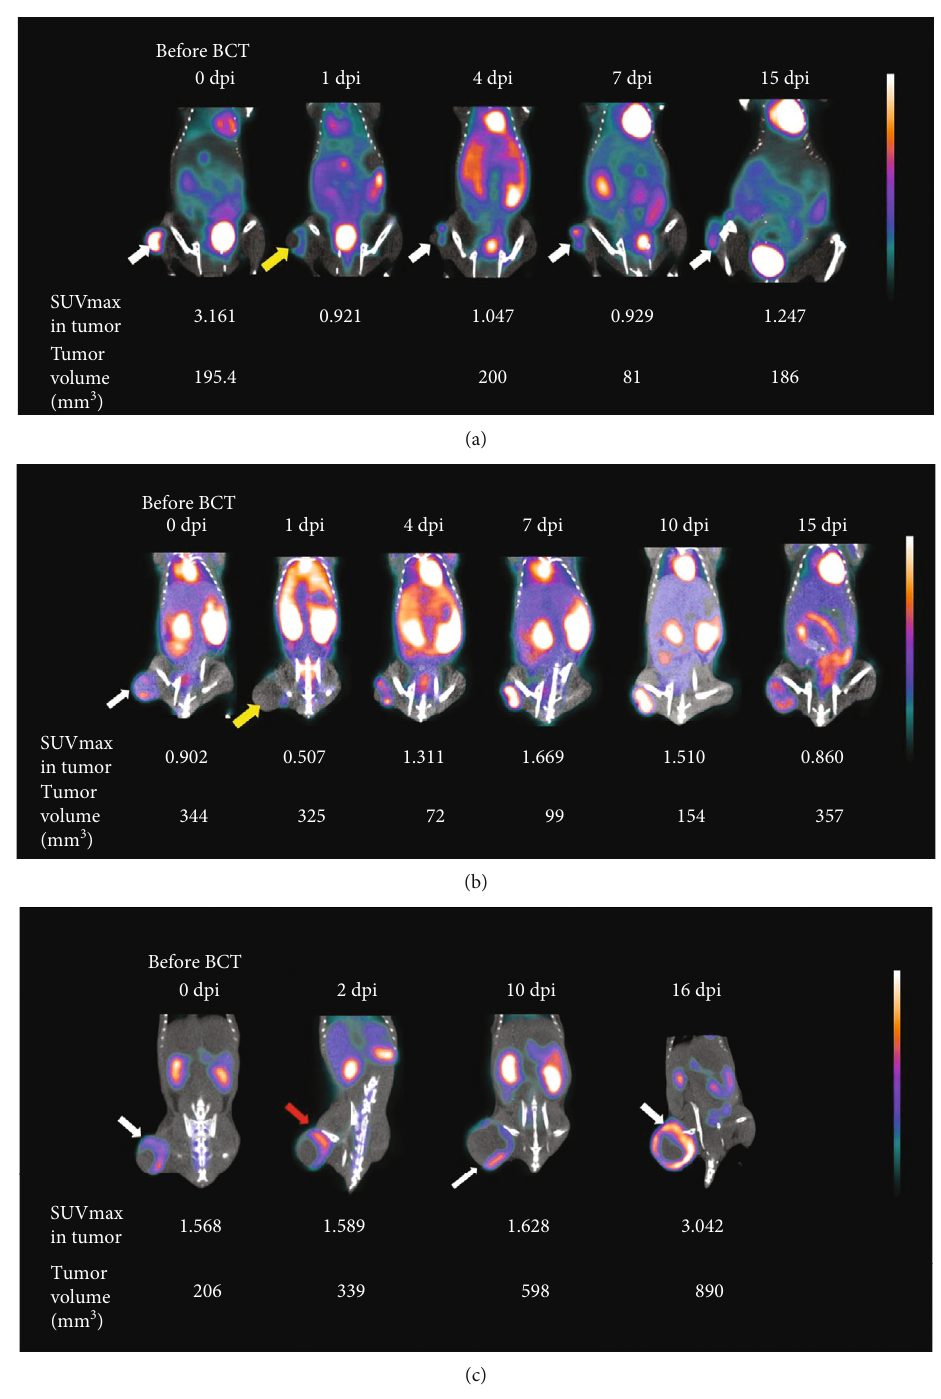
Figure 2: Three representative FDG PET/CT images after bacterial cancer therapy (BCT) using engineered Salmonella typhimurium . A tumor was generated in the right thigh of each mouse (BALB/c female mice, 6-weeks-old) using murine CT26 colon adenocarcinoma cells. After the tumor volume reached at least 180mm 3 , BCT was performed by the intravenous injection of bacterial cells via the tail vein ( bacterial dose = 4 : 5 × 10 7 CFU/mouse in 100 μ L PBS). FDG PET/CT images were acquired before and after BCT. Coronal PET/CT fusion images are shown. FDG uptake was measured as SUVmax. White arrows indicate FDG uptake in tumors before BCT (a – c). Yellow arrows (a & b) indicate decreased FDG uptake 1 day after BCT. The red arrow (c) indicates a tumor showing no decrease in FDG uptake after BCT. Abbreviations: FDG, 2-deoxy-2[ 18 F] fl uoro-D-glucose; dpi, days post-injection; SUVmax, maximum standardized uptake value; SUVmean, mean standardized uptake value; PBS, phosphate-bu ff ered saline. CFU, colony-forming